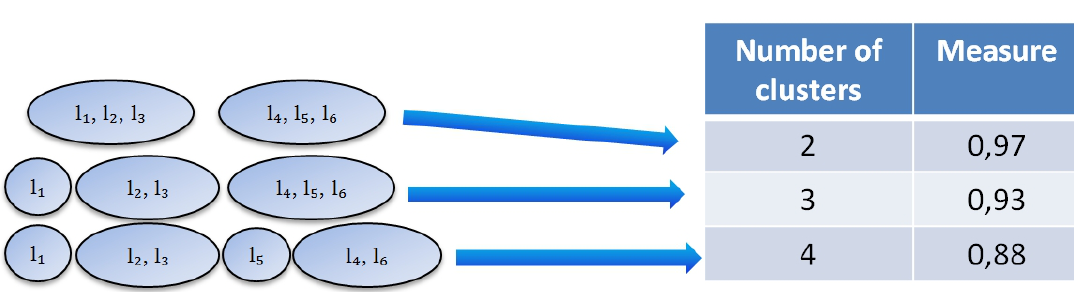
Figure 5. Example: filling in the